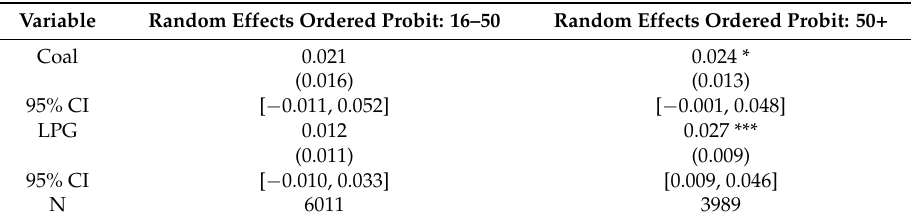
Table A4. Random effects ordered probit estimates for cooking fuel choice on women’s self-reported health in rural area: CFPS 2010–2012.